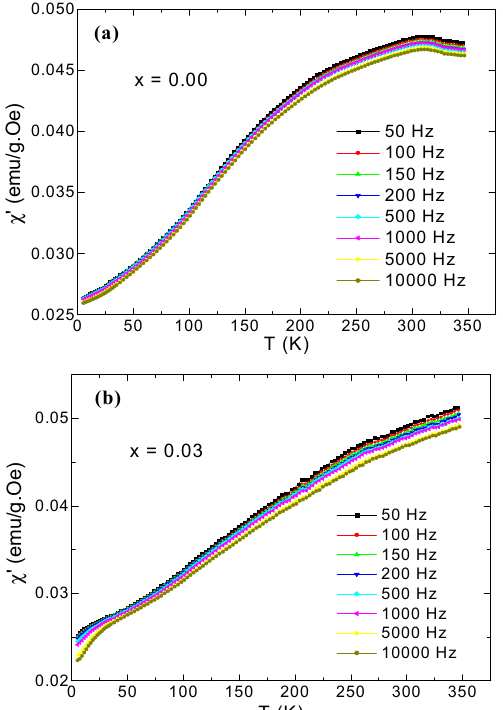
Figure 6. χ ’( T ) curves of the prepared ( a ) NiFe 2 O 4 and ( b ) NiFe 1.97 Dy 0.03 O 4 Figure 6. 𝜒′(𝑇) curves of the prepared ( a ) NiFe 2 O 4 and ( b ) NiFe 1.97 Dy 0.03 O 4 NPs